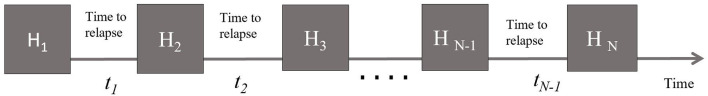
Schematic of a MH patient trajectory indicating hospitalizations and relapses.